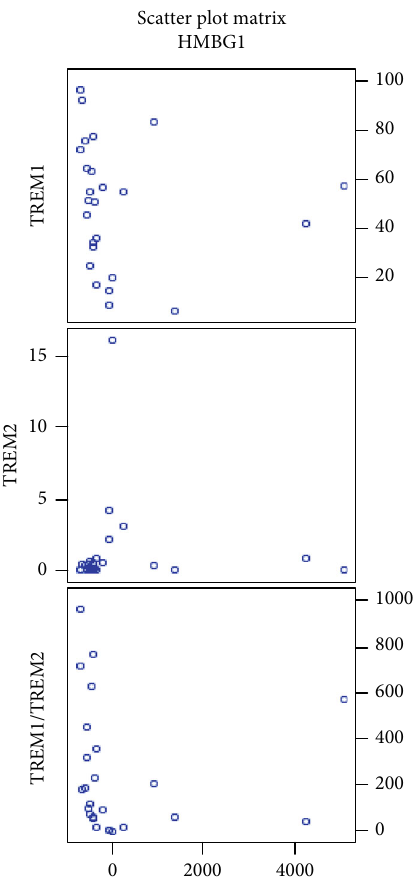
Figure 8: Scatter plots showing correlations of HMGB1 with percentage of CD14 + TREM-1 + cells, CD14 + TREM-2 + cells, and TREM-1/TREM-2 ratio in grade IV gliomas (HMGB1 values corrected by a Z